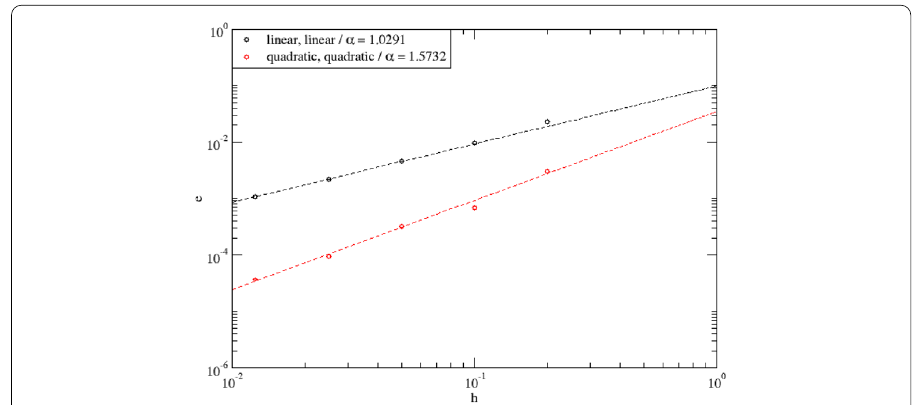
Fig. 40 Convergence rates on the relative error in terms of the energy norm with respect to mesh refinement for the quadratic patch test, using linear shape functions and a linear enrichment function (linear, linear) and quadratic shape functions and a quadratic enrichment function (quadratic,